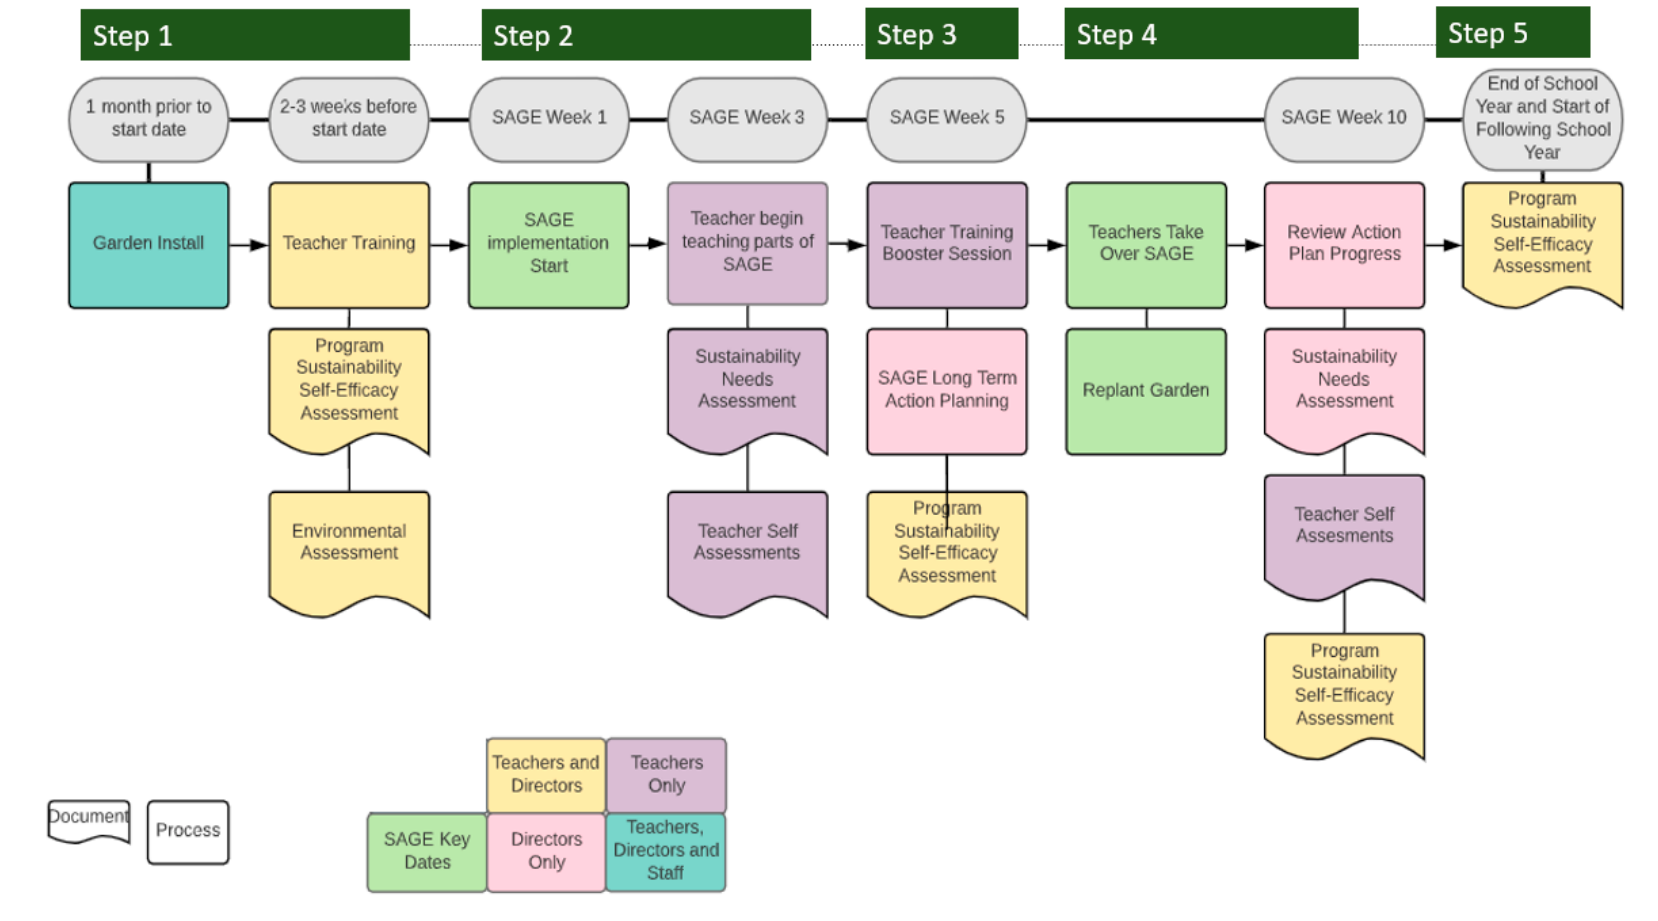
Figure 2. The SAGE SAP steps rollout process and measures by stakeholder.